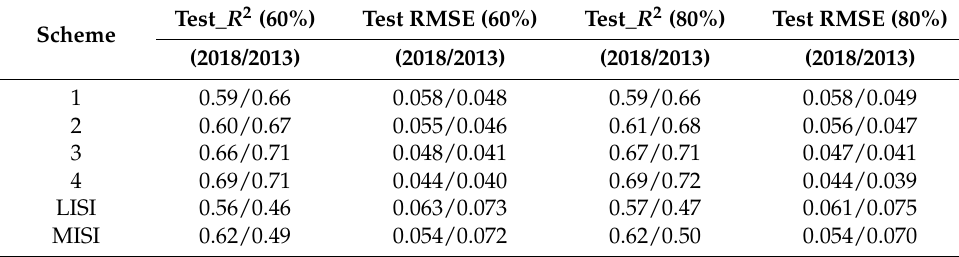
Table 4. Model prediction accuracy of AISP based on different schemes.